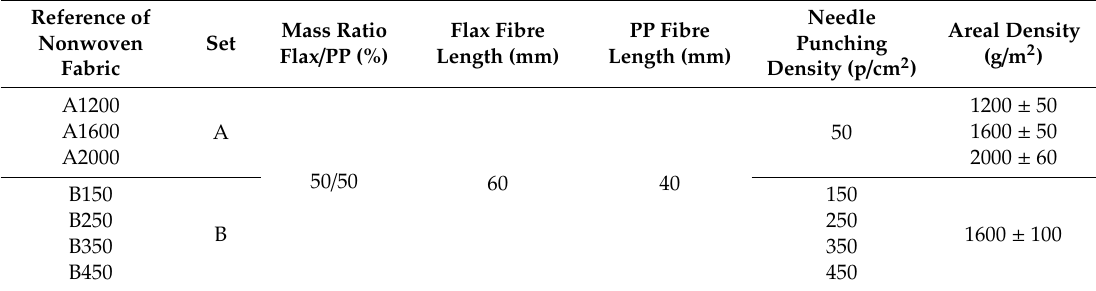
Table 1. The main properties of the nonwoven reinforcements.